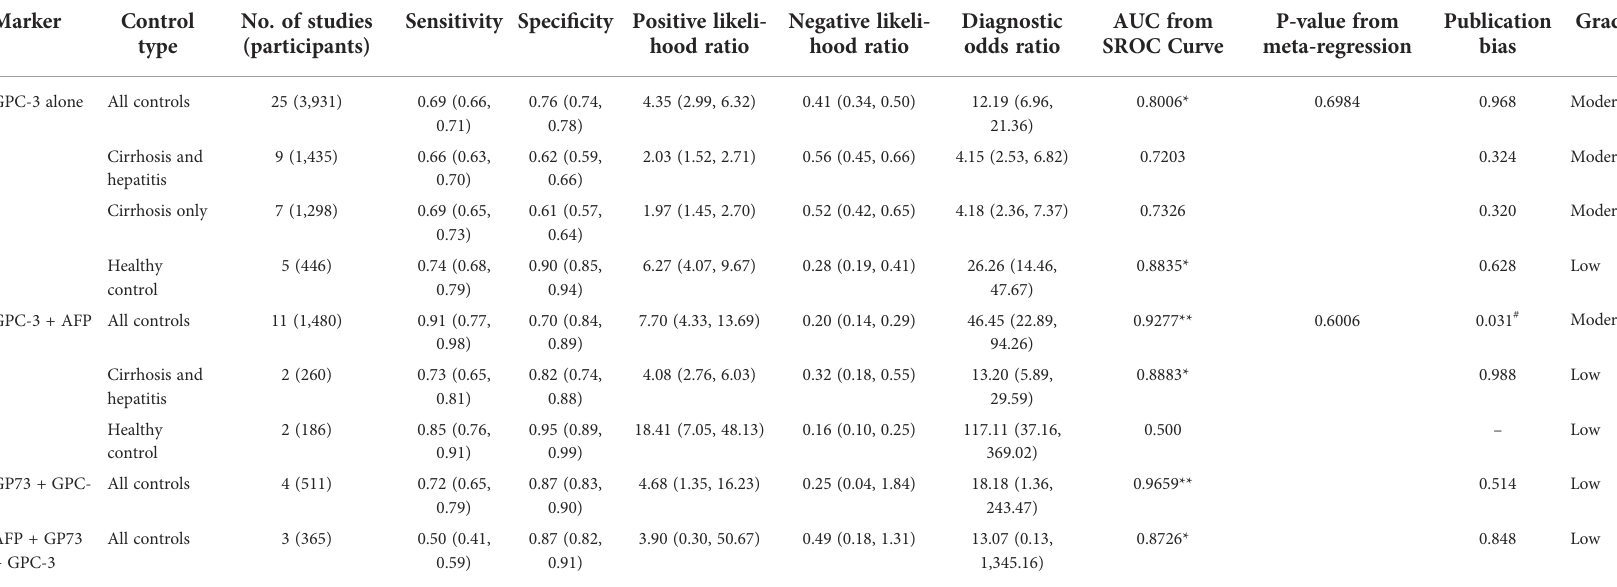
TABLE 2 Summarized of pooled sensitivity, speci fi city, positive likelihood ratio, negative likelihood ratio, diagnostic odds ratio, and SROC curve of GPC-3 in diagnosing hepatocellular carcinoma patients from